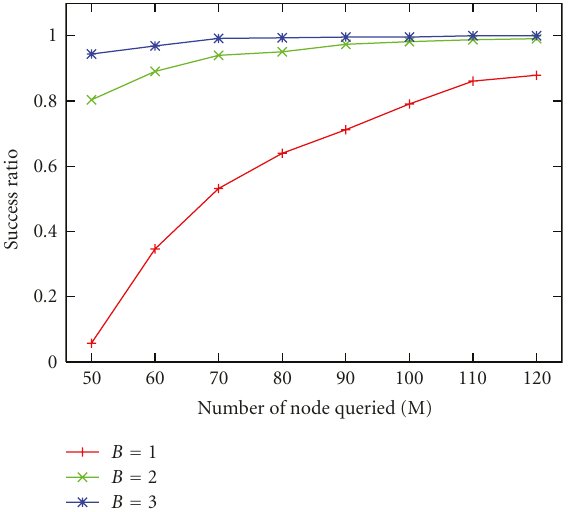
Figure 8: Success ratio as a function of λ = M/N